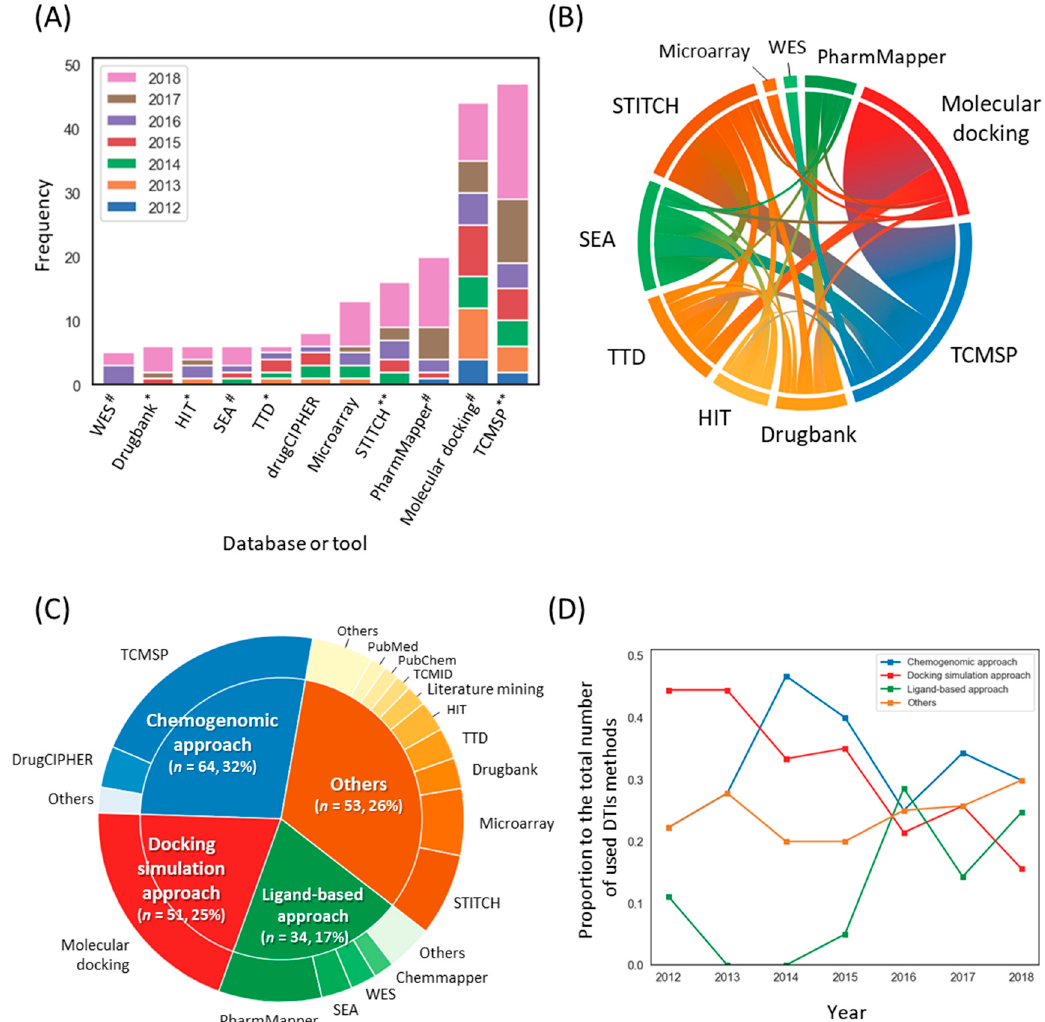
Figure 5. Methodological trends in the construction of the compound–target network. ( A ) The frequencies of databases and tools used to identify targets of herbal ingredients. * databases that provide validated drug-target interactions (DTIs); ** databases that provide both validated and predicted DTIs; # Computational tools to predict DTIs. ( B ) A co-occurrence pattern of the DTI method. ( C ) Categories of DTI methods and their composition. The outer circle and inner circle represent the DTI methods and their categories, respectively. ( D ) The annual rate of the groups of DTI methods. Note that THM-NP studies in 2011 were excluded from the visualization due to their low frequency ( n = 2). TCMSP, Traditional Chinese Medicine Systems Pharmacology Database; TTD, Therapeutic Target Database; SEA, Similarity Ensemble Approach; HIT, Herb Ingredients’ Targets; WES, Weighted Ensemble Similarity.